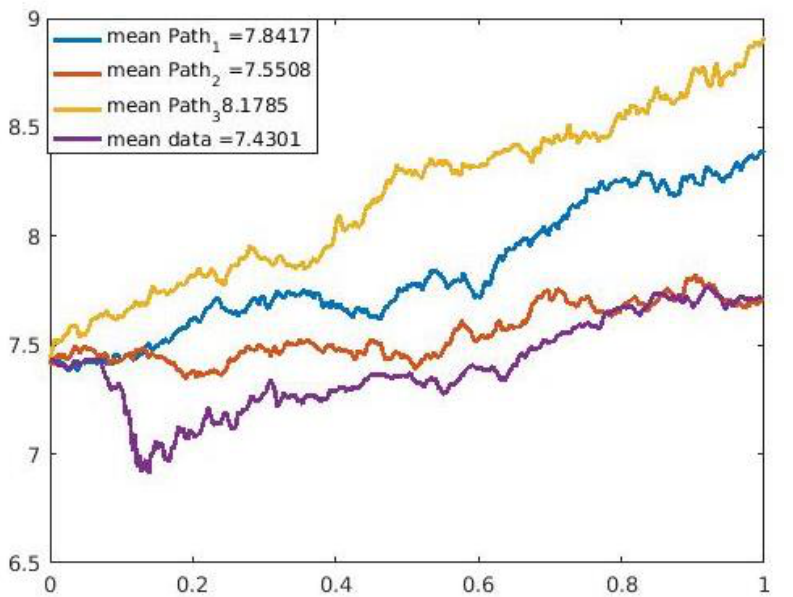
Figure 11. Graph showing three sample paths and time series plot for the Russell index. For this time series, we see that sample path 2 closely predicts it and by comparison of the means, sample path 2 is closer in value to the mean of the time series data.